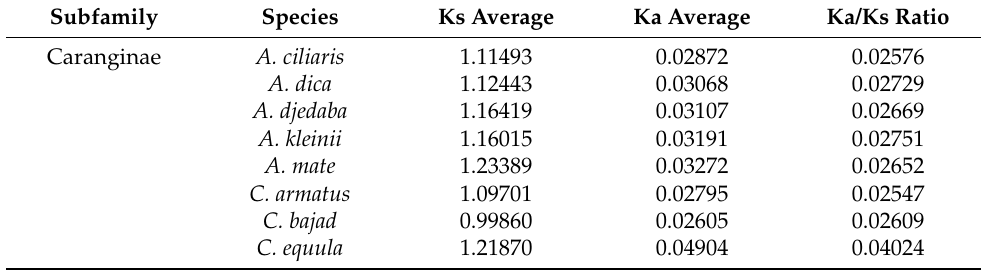
Table 4. The mean values of the Ka/Ks ratio for the PCGs in the pairwise mitochondrial genome among the Carangidae